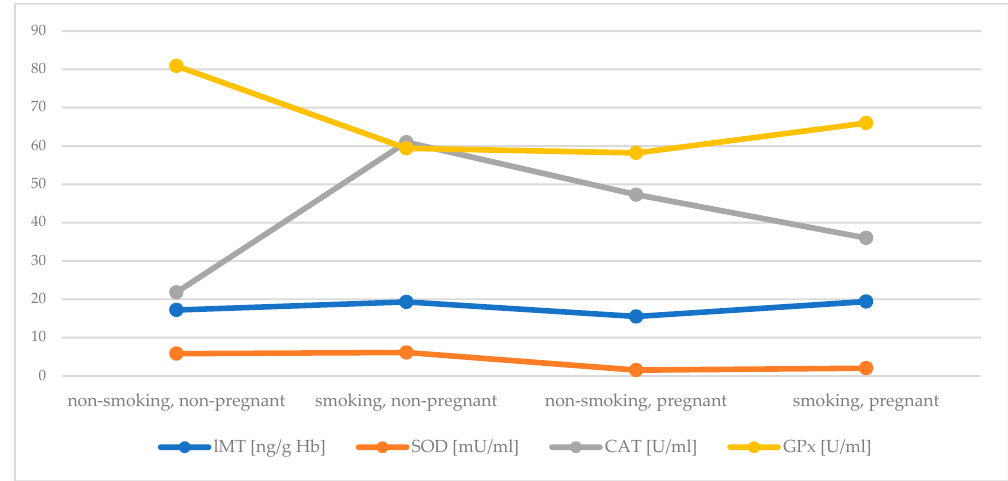
Figure 2. Comparison of the concentartion of MT in lysate and the activity of SOD, CAT and GPx between groups.